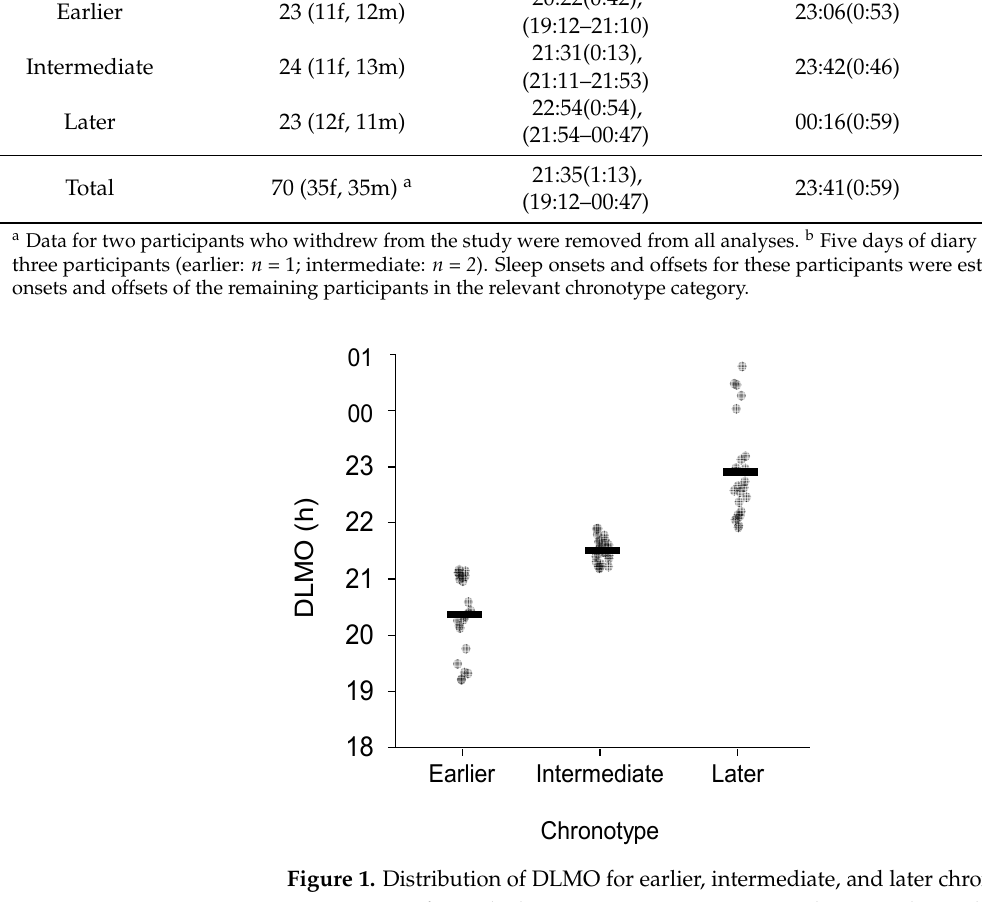
Table 2. DLMO means, standard deviations, and ranges, and habitual sleep onset and offset means and standard deviations for earlier, intermediate, and later chronotypes. Chronotype